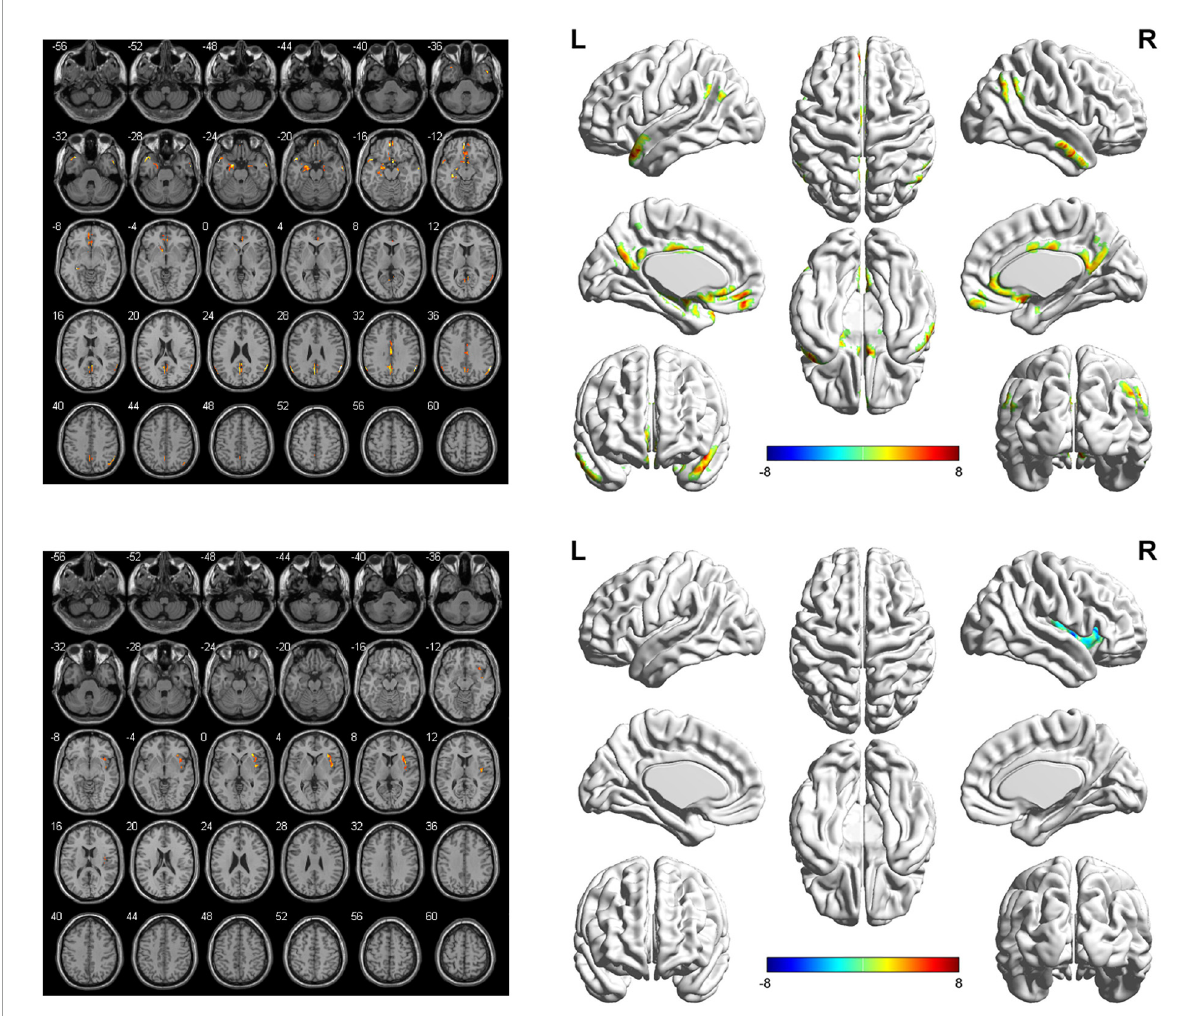
FIGURE2 Right-side SFGmed-based resting-state functional connectivity analysis between patients with ruptured ACoA aneurysm and healthy controls. Results were represented in 2D (left) and 3D (right), respectively. The color bar represents T-scores. Brain regions labeling with color indicate decreased (top panel) or increased functional connectivity (bottom panel) in patients with ruptured ACoA aneurysm as compared to the healthy controls. The threshold for displaying was set to p < 0.05, false discovery rate corrected, and cluster size > 50. Details of these color regions are given in Table 2 . SFGmed, medial superior frontal gyrus; ACoA, anterior communicating artery; L, left; R,